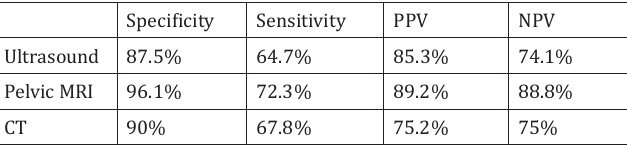
Evaluation of imaging